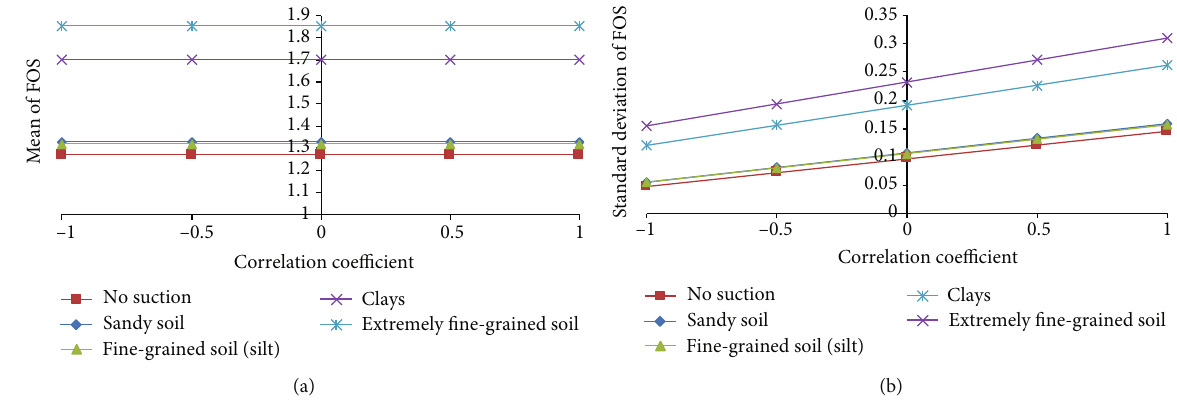
Figure 3: Mean and standard deviation of FOS under di ff erent correlation coe ffi cients for four di ff erent soils: (a) mean and (b) standard